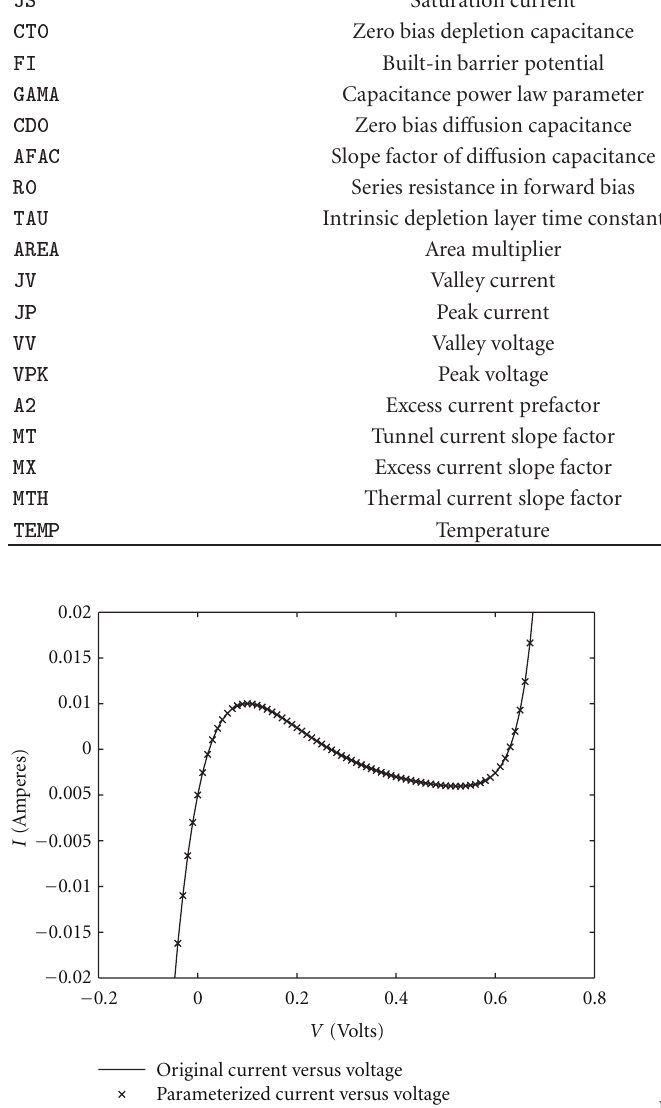
Figure 6: Original Esaki tunnel diode I - V characteristic compared with the parameterised I - V characteristic.